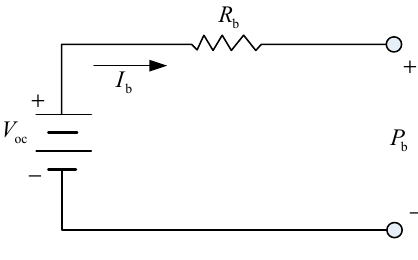
Figure 4. The simplified battery model.